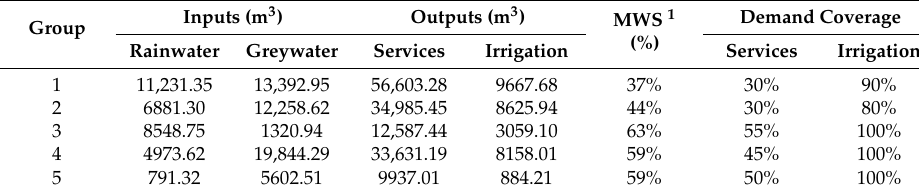
Table 6. Water inputs and outputs, water savings and coverage of water demands.